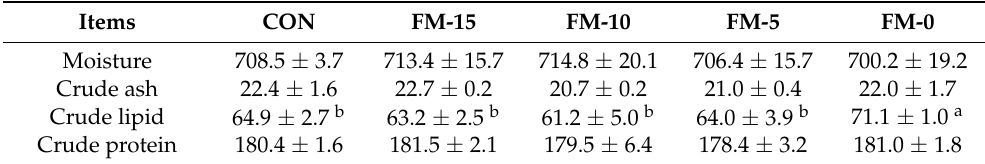
Table 4. Effect of replacing fishmeal with CPC and CAP mixture on whole-body composition of rainbow trout (fresh weight, g/kg).